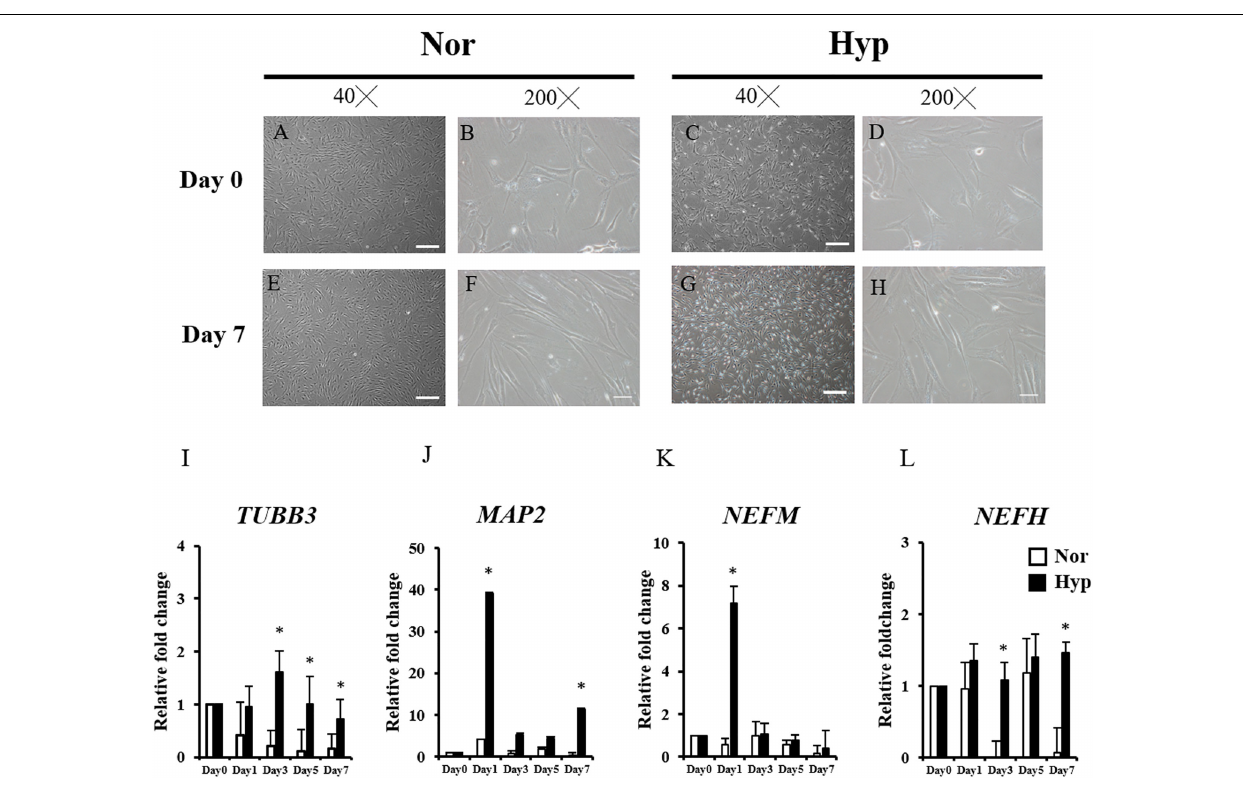
FIGURE 2 | Morphology and neuron-associated gene expressions of ADSC differentiated neuron-like cells. The morphologies of undifferentiated ADSCs expanded in normoxia (A,B) and hypoxia (C,D) before induction (Day 0) were examined using phase-contrast microscopy. The neuron-like morphologies differentiated from the normoxic (E,F) hypoxic ADSCs (G,H) under normoxia were observed on day 7 by β -ME induction. (Magnification × 40; the scale bar = 200 µ m; magnification × 200; the scale bar = 50 µ m). Genes including Class III β -tubulin ( TUBB3 ) (I) , microtubule-associated protein 2 ( MAP2 ) (J) , neurofilament medium polypeptide ( NEFM ) (K) , and neurofilament heavy polypeptide ( NEFH ) (L) of the normoxic and hypoxic ADSC differentiated cells were detected by RT-qPCR from days 0 to 7, and all the gene expression values were normalized to the expression of glyceraldehyde-3-phosphate dehydrogenase ( GAPDH ). The values from day 1 to day 7 were compared with those of day 0 to show the relative fold change. The values were presented as mean ± SD with three replicates of the experiments. Statistical significances between the two groups were analyzed using the Mann-Whitney U -test. “ ∗ ” represented P <